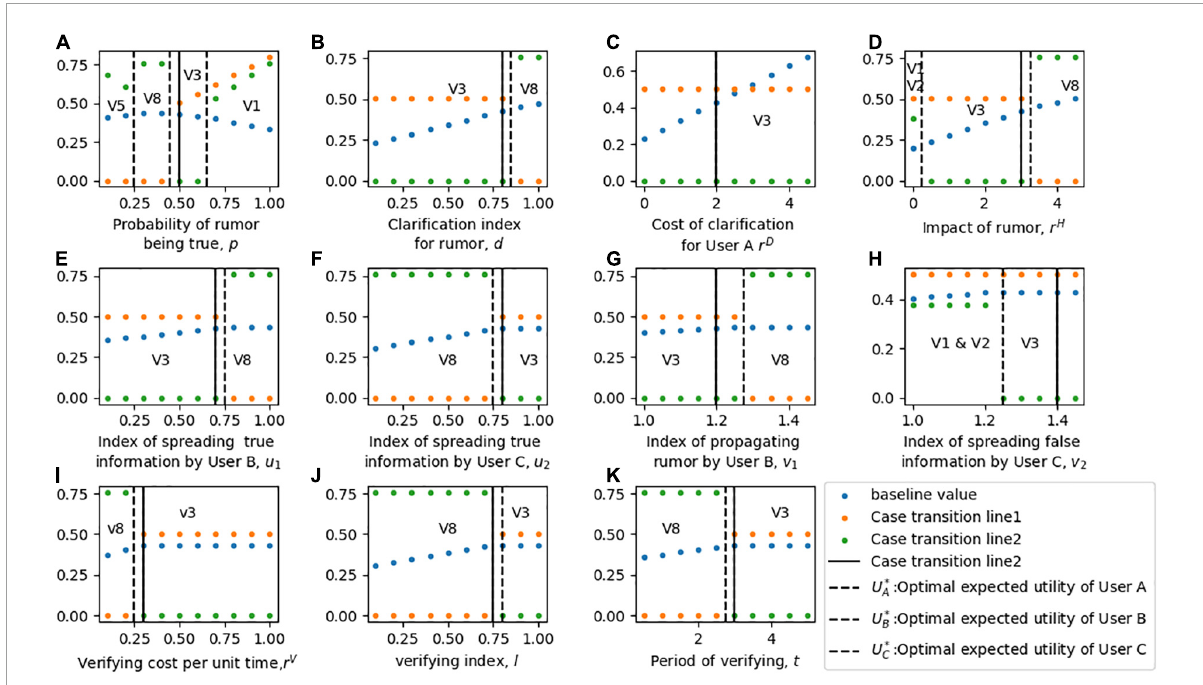
FIGURE6 Sensitivity analysis of the optimal strategies and expected utilities of three players in Model 2. For part panel (A–K) , the x-axis represents the change of each parameter, the y-axis indicates the sensitivity of the equilibrium solution. V1-V8 in the part labels represents the different cases of strategy combination. The solid vertical line represents the baseline value of each parameter, and the dotted vertical line represents the transition of each